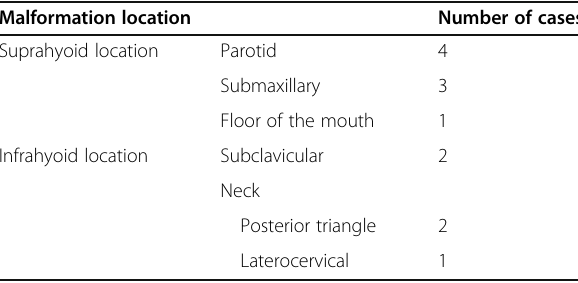
Table 1 Distribution of lesions according to